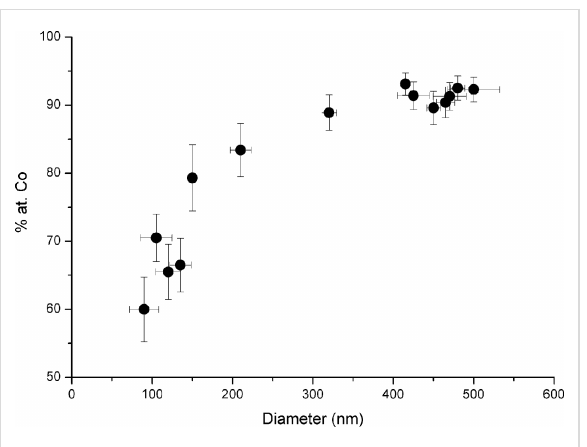
Figure 2: Composition of the cobalt nanospheres, as measured by EDX, as a function of diameter.